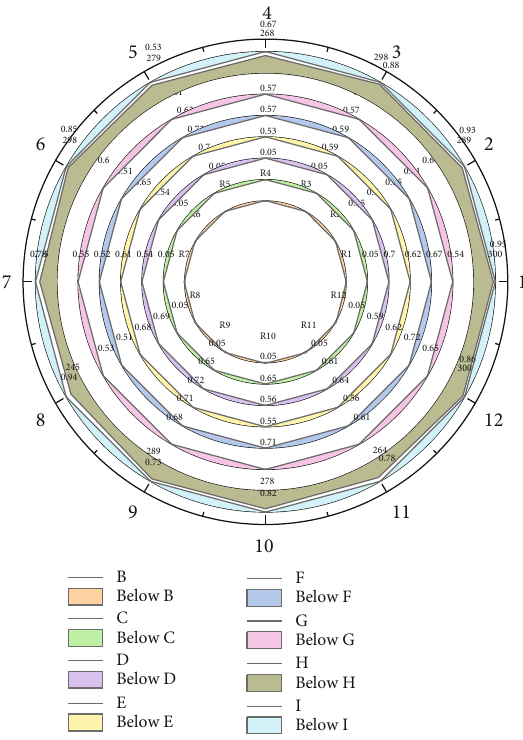
Figure 6: Results of crossvalidation